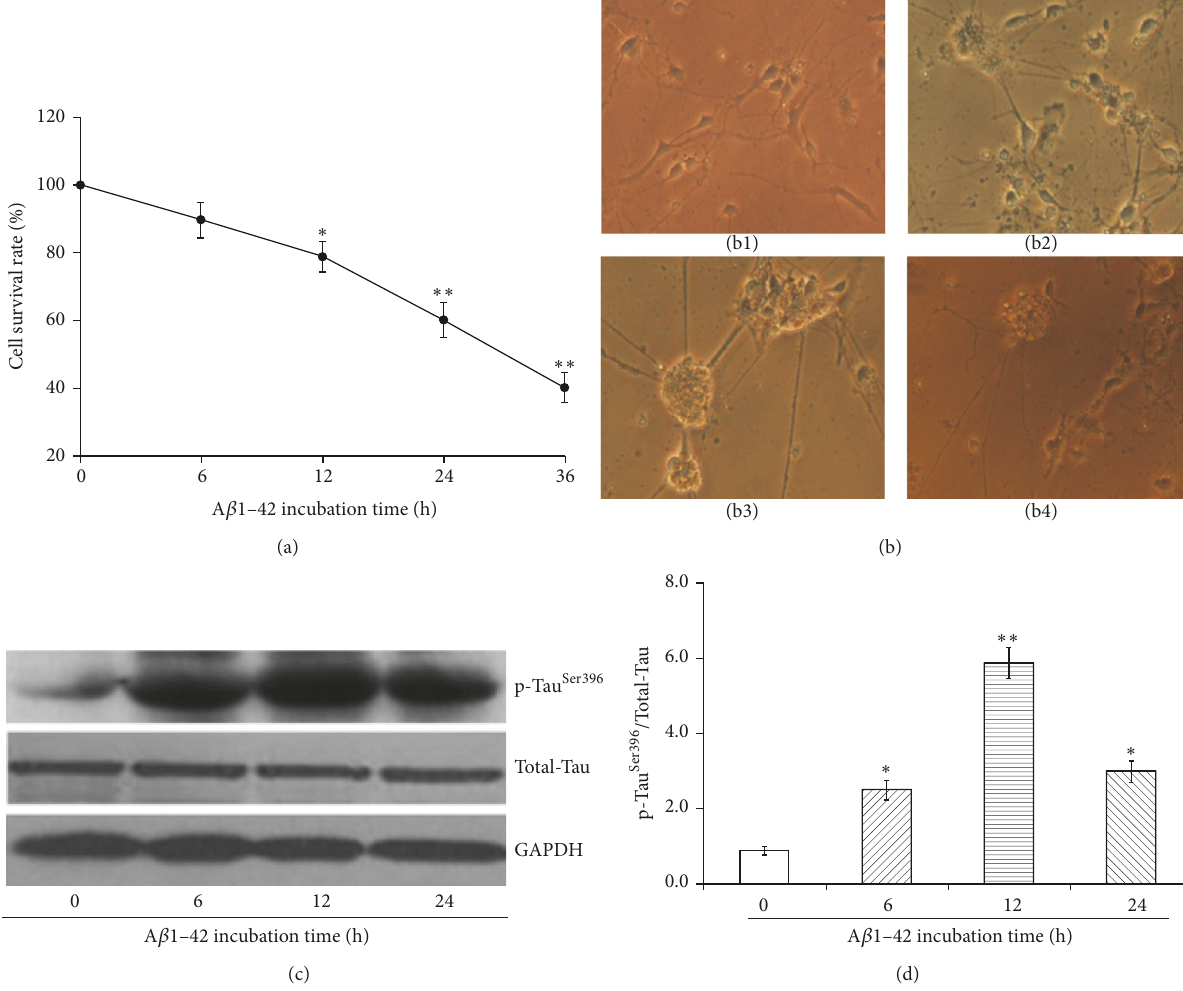
Figure 3: The cell growth inhibition (a), characteristic morphological changes (b), and expression of p-Tau Ser 396 protein (c, d) of hippocampal neurons in the presence of A 𝛽 1–42 induction ( ∗ 𝑃 < 0.05 , ∗∗ 𝑃 < 0.01 ).